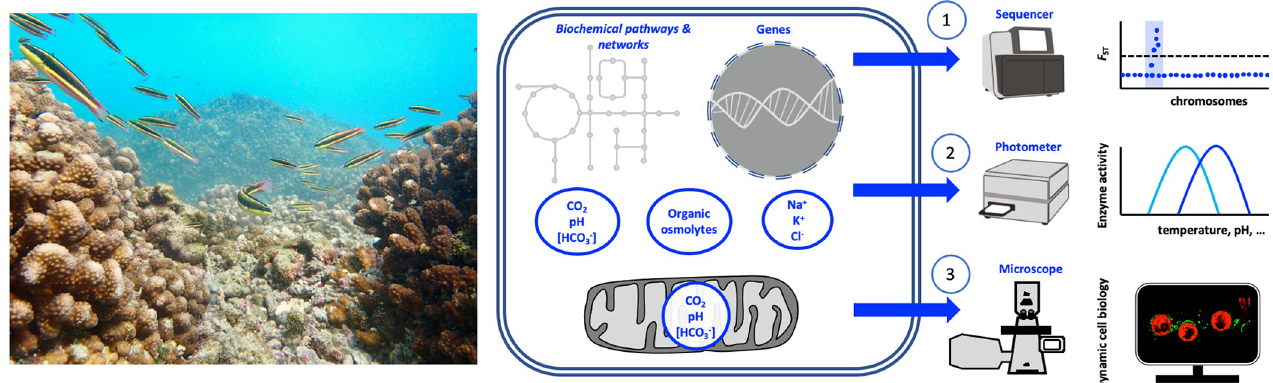
Fig 1. Cooperation between scientists specializing in “omics” and marine CBP is essential for understanding responses and rapid evolution to climate change. Left: Coral reefs are endangered by climate change and harbor thousands of marine species with unique CBP adaptations to their environments ( image credit : M . Tresguerres . Taken at Parque Nacional Cabo Pulmo , Baja California Sur , Mexico ). Middle: Cells contain complex fluids with defined carbonate chemistry and dissolved organic and inorganic molecules. The roles of many genes, their coded proteins, and their emerging cellular functions are unknown in many marine animals, especially invertebrates. Right: Genome scans (1) can give us information on genetic differentiation ( F ST ) of populations selected by climate change-relevant stressors (e.g., temperature or pH). Genomic regions under selection (light blue region) can then be further characterized using CBP methods (shown in 2 and 3). In vitro enzymatic assays (2) can help us understand how mutations (SNPs) in genes under selection can enhance protein function under novel abiotic regimes. These assays require knowledge of cellular fluid composition. Dynamic cell biology approaches (3) can help us elucidate the physiological functions of proteins that are targets of selection ( image credit : Angus Thies , Tresguerres Lab ). C AU : AnabbreviationlisthasbeencompiledforthoseusedthroughoutFig 1 : Pleaseverifythatallentriesarecorrect : BP, cellular biochemistry and physiology; SNP, single nucleotide polymorphism.